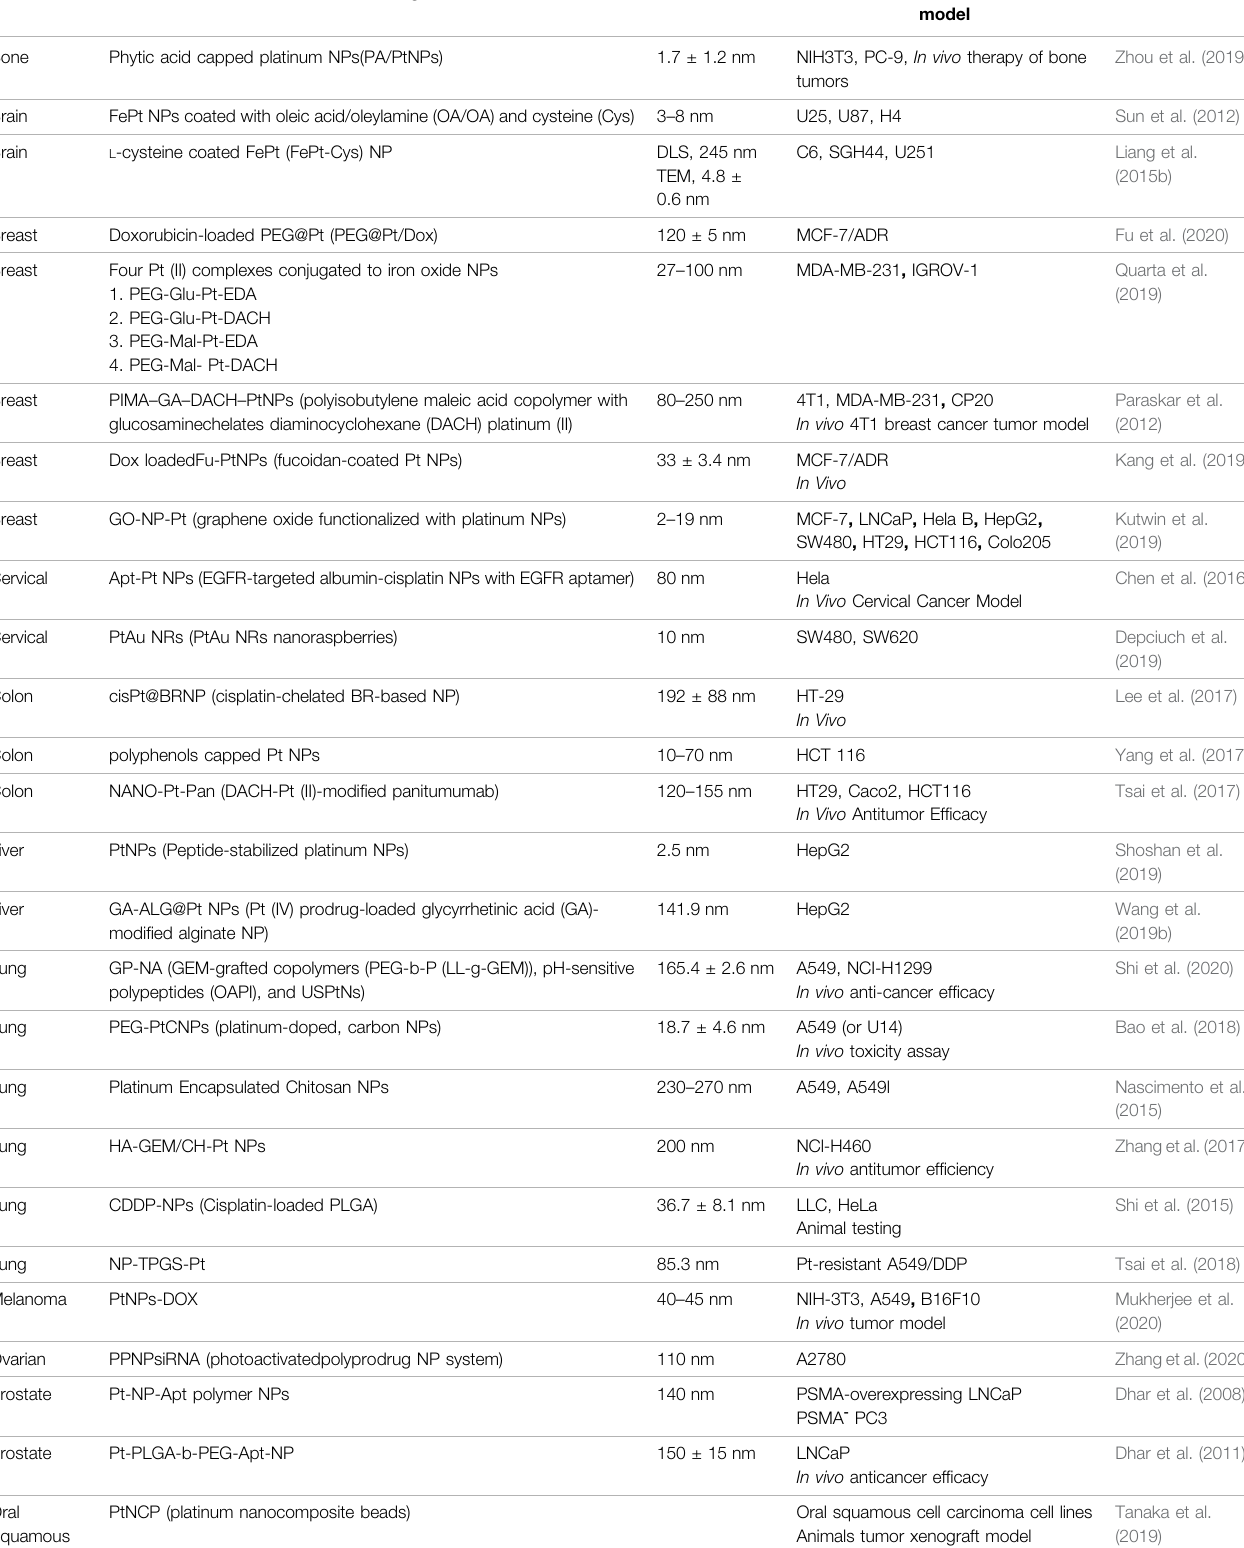
TABLE 2 | PtNPs used to deliver drugs or therapeutic agents to different tumors.